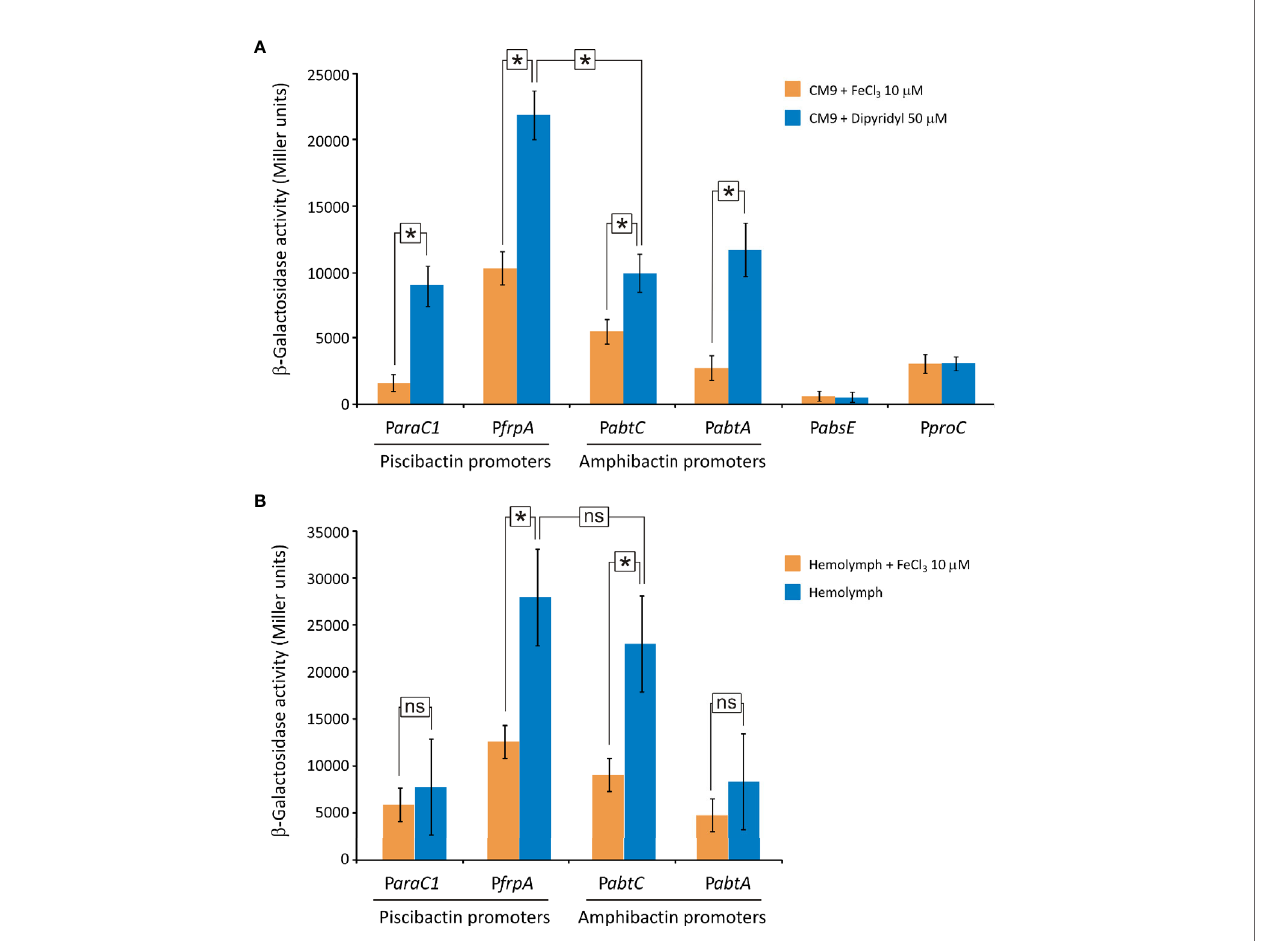
FIGURE 8 | Transcriptional activity ( b -galactosidase units) of piscibactin (P araC1 and P frpA ) and amphibactin (P abtC and P abtA ) promoters carried out using lacZ fusions. Expression assay was performed in vitro by cultivating V. neptunius PP-145.98 in CM9 minimal medium supplemented with FeCl 3 10 µM (iron excess) or 2,2 ’ -dipyridyl 50 µM (iron de fi ciency) (A) and ex vivo by cultivating bacteria in mussel hemolymph (B) . P abtA promoter cloned in reverse orientation upstream of the lacZ gene was used as a negative control. A lacZ fusion with the constitutive promoter proC (P proC ) was used as control. Asterisks indicate statistically signi fi cant differences between bars ( P < 0.05); ns, no statistically signi fi cant differences. Error bars denote standard